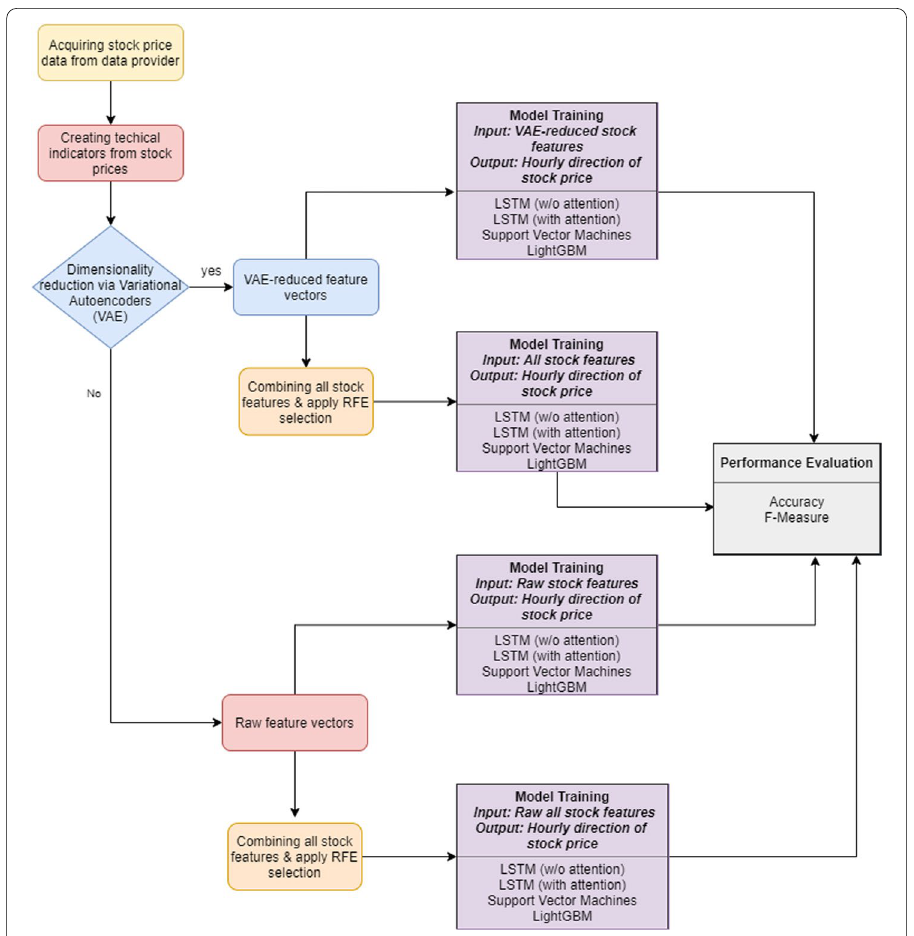
Fig. 1 A graphical view of proposed